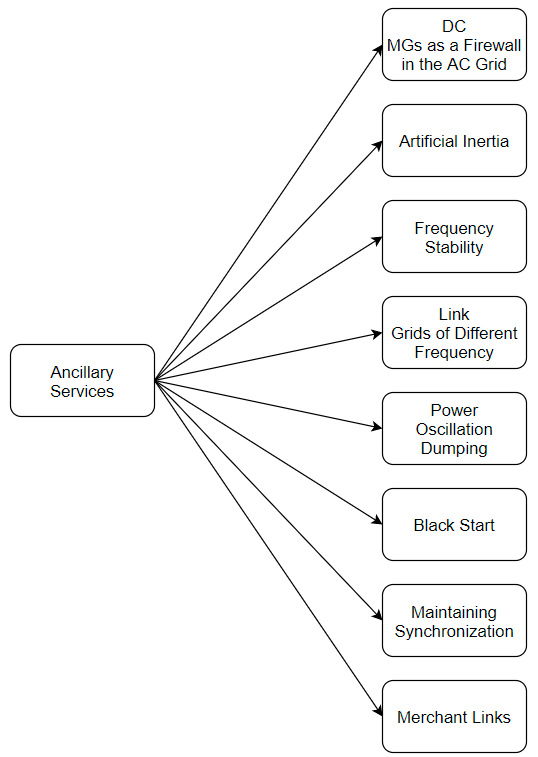
Figure 11. Ancillary services.